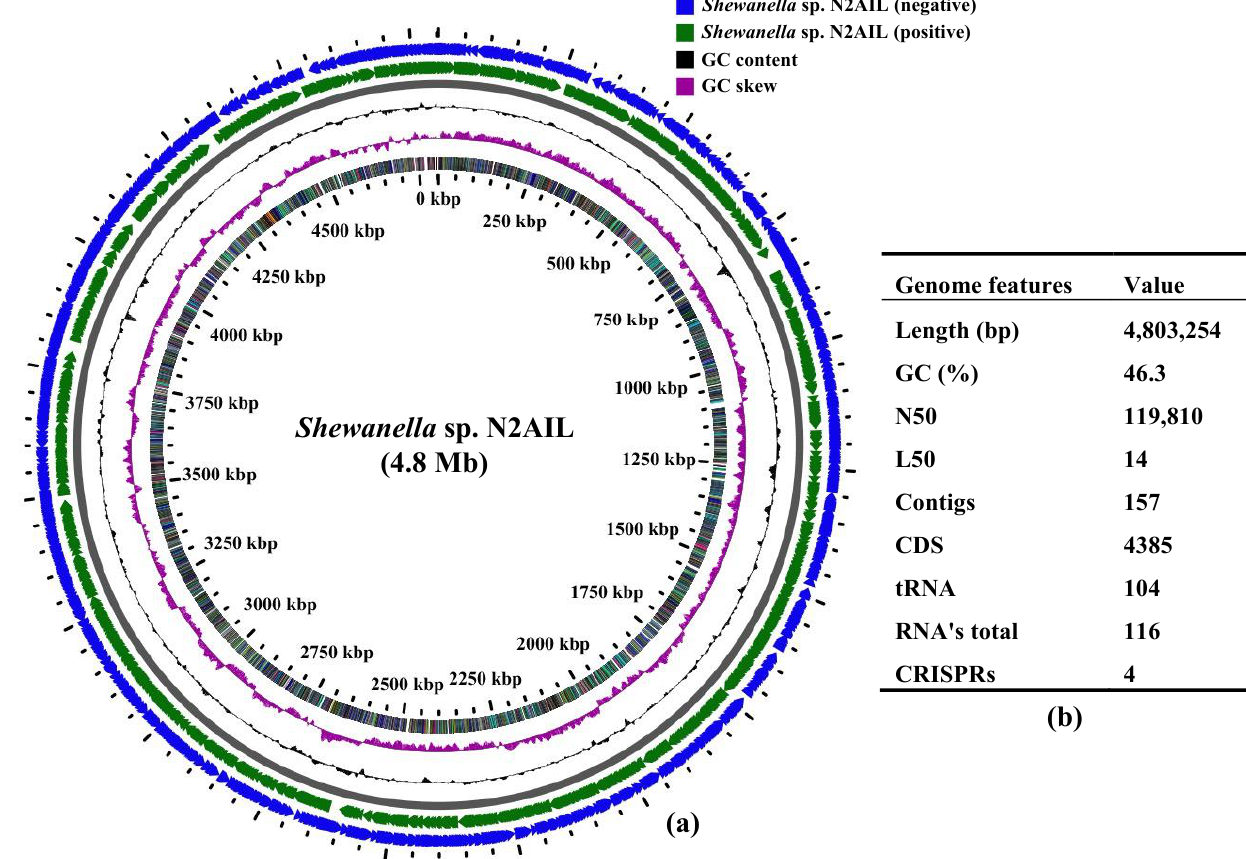
Figure 1. Circular genome map of Shewanella sp. N2AIL. Circles from the outside to inside showing: (1) Antisense strand (2) Sense strand (3) GC content and (4) GC skew ( a ), and table showing its general genome features ( b ).